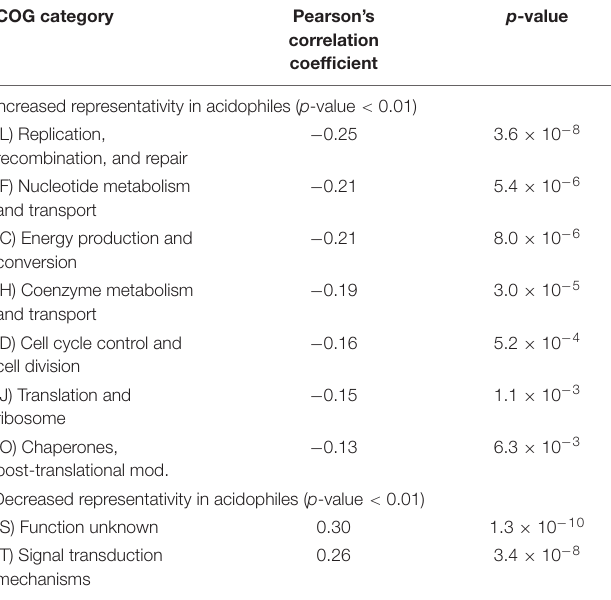
TABLE 1 | Genomic representativity of protein families by function as defined by Clusters of Orthologous Genes (COG) categories in acidophile genomes. COG category Pearson’s p -value correlation coefficient Increased representativity in acidophiles ( p -value <